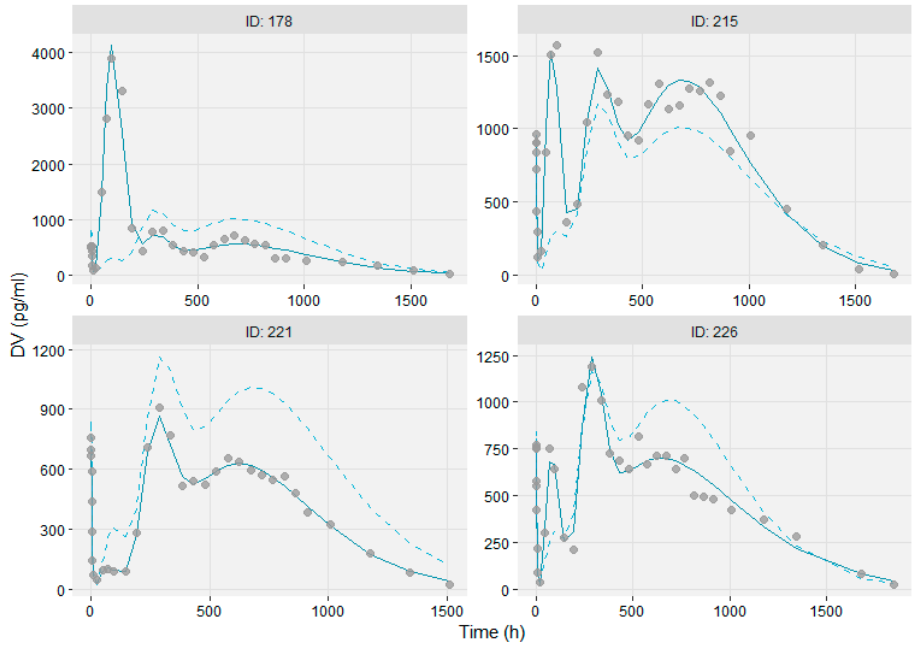
Figure 3. Individual plots of Observations vs PRED and IPRED showing the flexibility of the PPK model to predict for four representative subjects. Solid line and dashed line indicate IPRED and PRED, respectively.